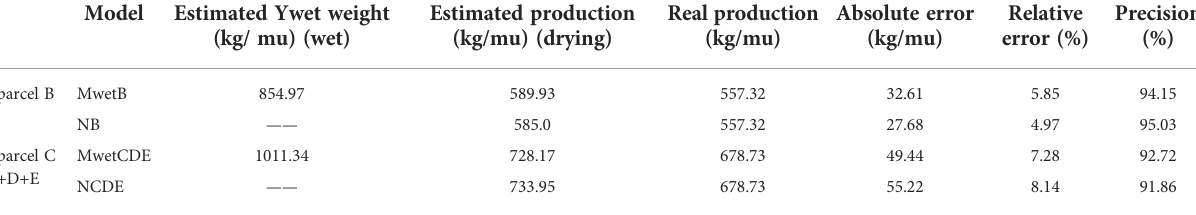
TABLE 3 Veri fi cation of model yield estimate accuracy.